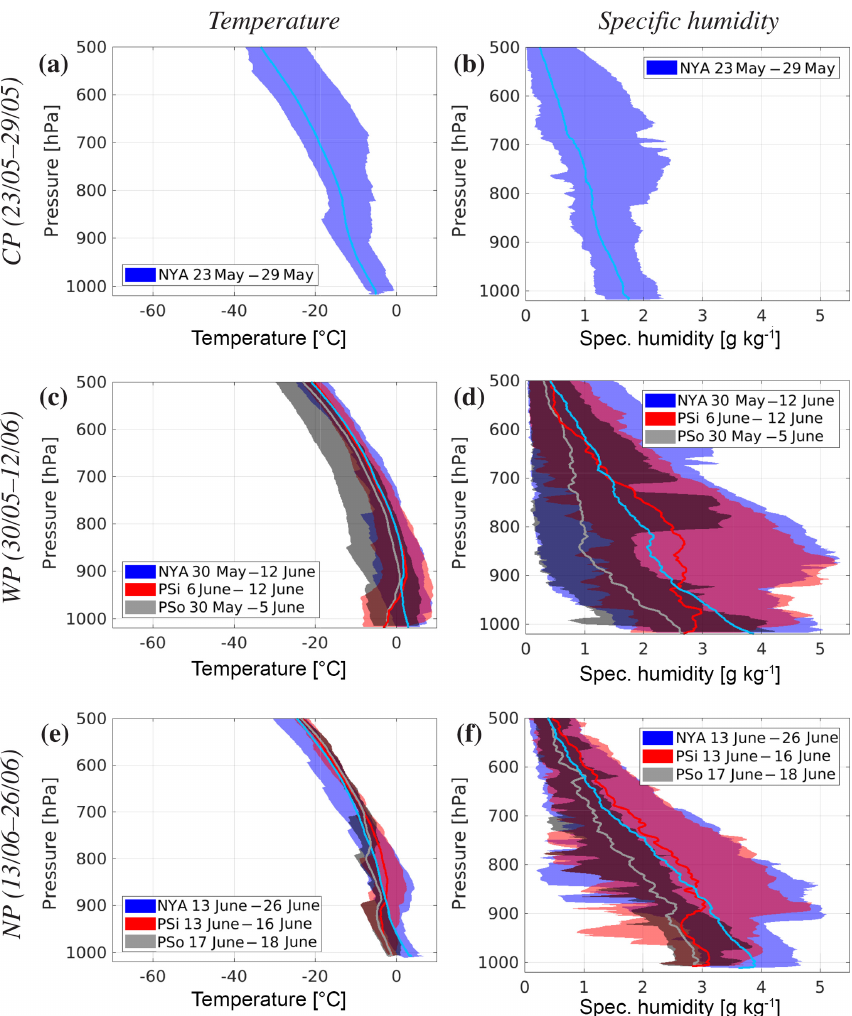
Figure 8. Average (graphs) and minimum-to-maximum range (shading) vertical profiles of (a, c, e) temperature and (b, d, f) specific humidity for each ACLOUD/PASCAL key period from Ny-Ålesund (blue) and Polarstern (red for ice-attached dates, gray for cruising dates). Key periods are defined as (a, b) the cold period (CP), (c, d) the warm period (WP), and (e, f) the normal period